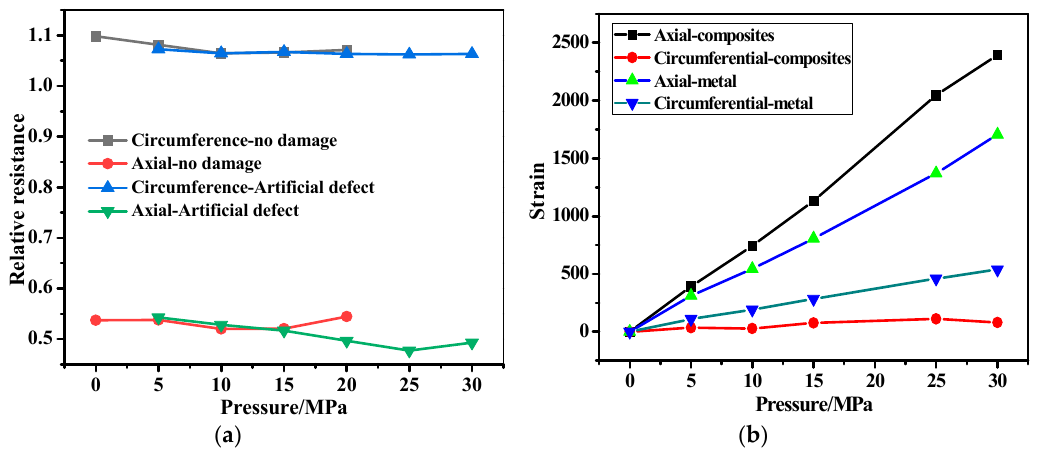
( b ) Resistance, strain–pressure time.